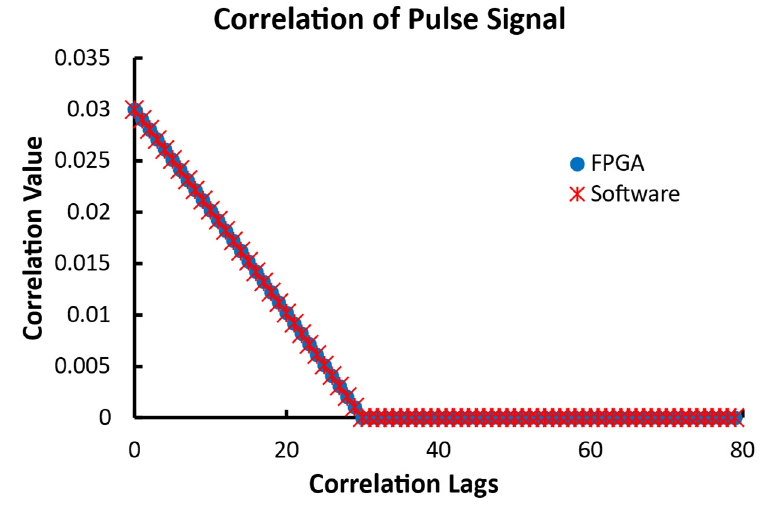
Figure 13. The outputs of 80 correlation lags of a pulse with 30 data points of value 1 followed by 970 zeros from the linear FPGA correlator and the software correlator.